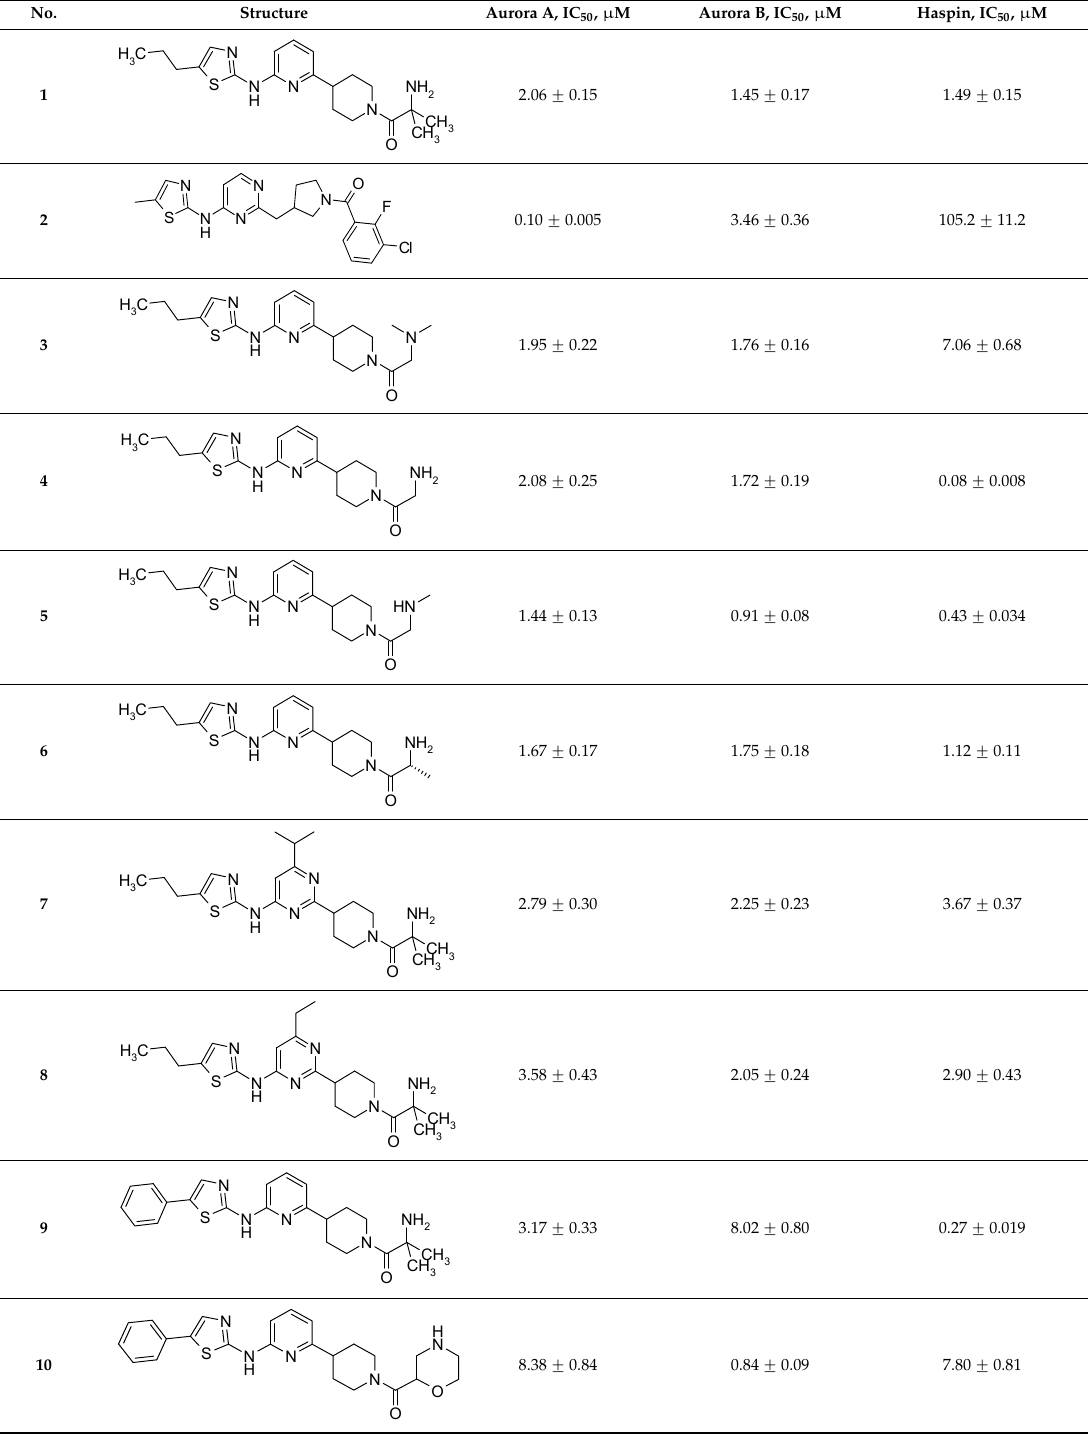
Table 1. Activity of compounds fitting to general pharmacophore model against selected Ser/Thr kinases.